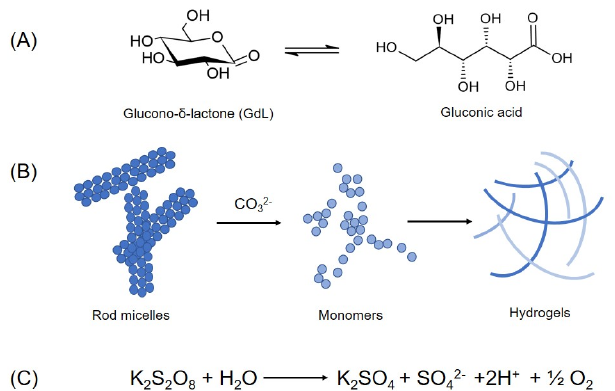
Figure 4. Preparation of Fmoc-FF hydrogel using three variants of the classic pH-switch method employing HCl: ( A ) decrease in pH induced by the slow hydrolysis ( ≈ 18 h) of the glucono- δ -lactone (GdL) to gluconic acid; ( B ) the colloid method in which the hydrogel is obtained by a progressive colloid-to-hydrogel transition triggered by adding of Na 2 CO 3 to the colloid solution; ( C ) decrease in pH allowed by the decomposition of the K 2 S 2 O 8 in oxygen gas and protons.